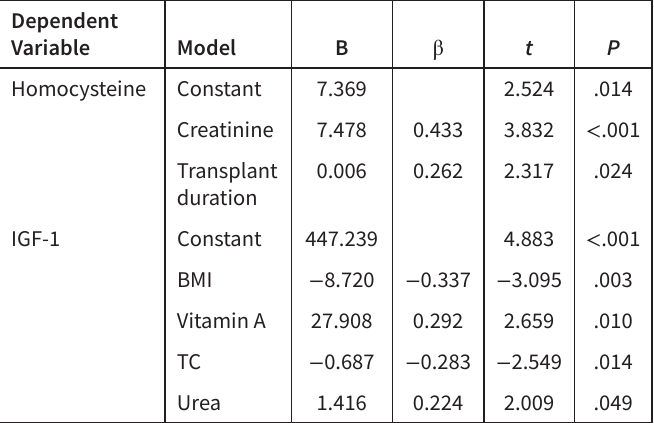
Table 4. Determinants of Homocysteine and Insulin-Like Growth Factor-1 Levels by Multiple Regression